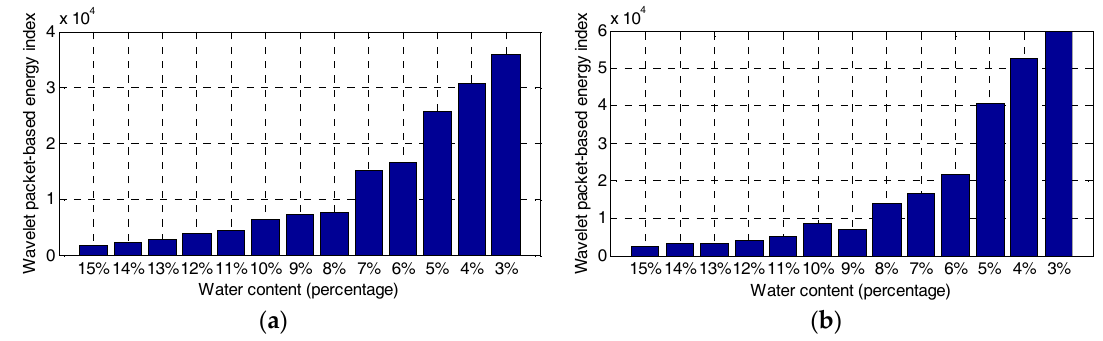
Figure 6. Wavelet packet-based energy index. ( a ) Specimen 1, ( b ) Specimen 2.